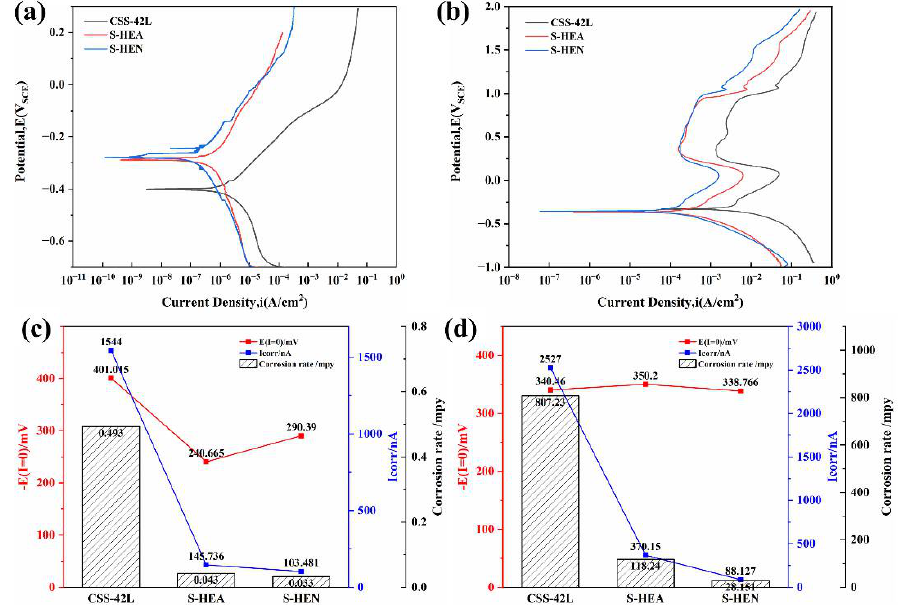
Figure 7. Potentiodynamic polarization curves and fitting parameters of S-HEA/S-HEN and CSS-42L steel samples in different corrosive fluids: ( a , b ) 3.5 wt.% NaCl, ( c , d ) 1 mol/L H 2 SO 4 .